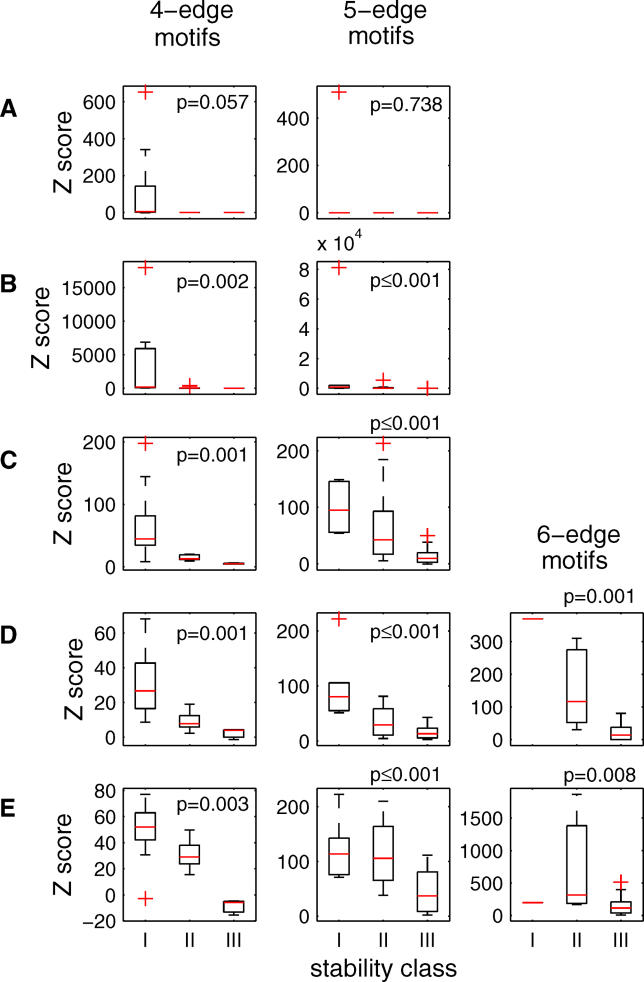
Z Scores of Four-Node Network Motifs, Classified by StabilityDensity groups consisting of four, five, and six-edge network motifs contain at least one motif in each stability class. Box and whisker plots indicate a difference in the average Z score between stability classes (I, II, and III correspond to SSS = 1, SSS ≈ 0.4, and SSS < 0.2, respectively). The networks examined here are the transcriptional networks of (A) E. coli, (B) S. cerevisiae, (C) STKE network, (D) D. melanogaster developmental transcriptional network, and (E) C. elegans neuronal network. A box and whisker plot is interpreted as follows: The box indicates the inner quartile range. The median Z score is indicated by a horizontal red line within the box. The whiskers extend to cover the upper and lower quartiles up to a distance of 1.5 times the inner quartile range. Red crosses indicate extreme scores (beyond the whisker length). P-values attached to each plot express the probability that the observed difference in Z scores between stability classes is expected by chance.